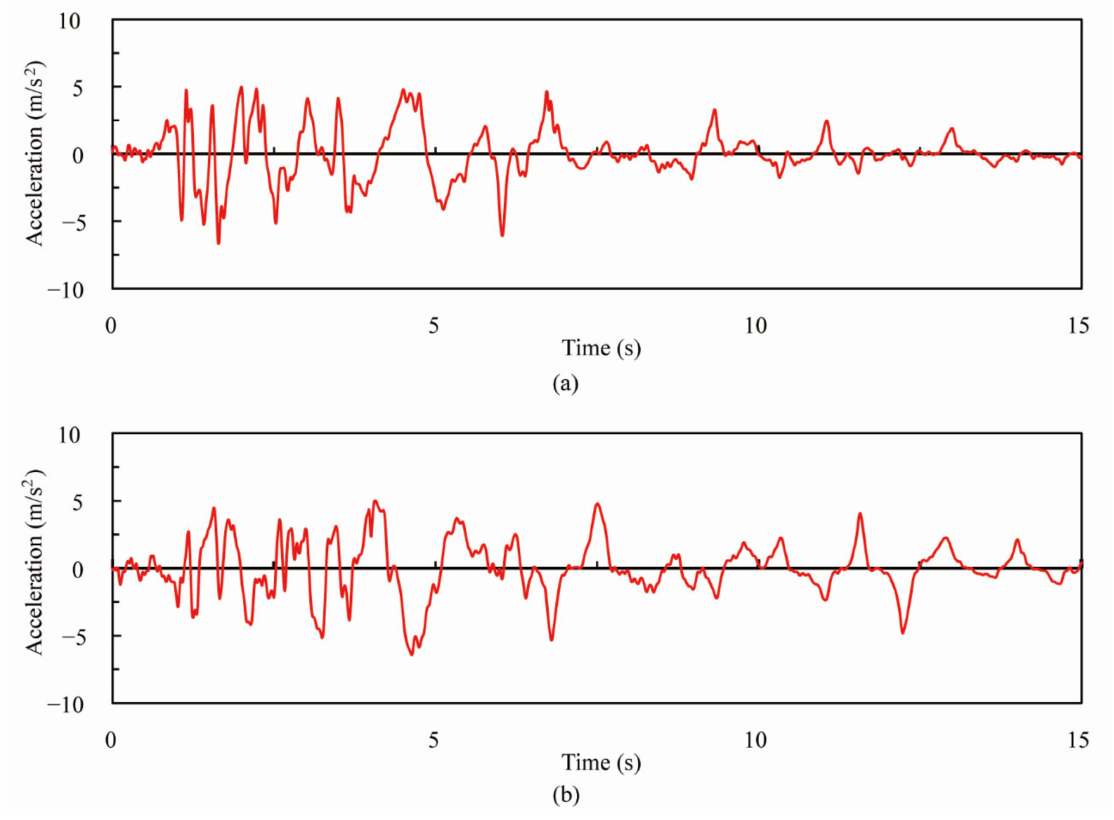
Figure 3. Acceleration record at JR Takatori Station during 1995 Kobe Earthquake. ( a ) EW direction, ( b ) NS